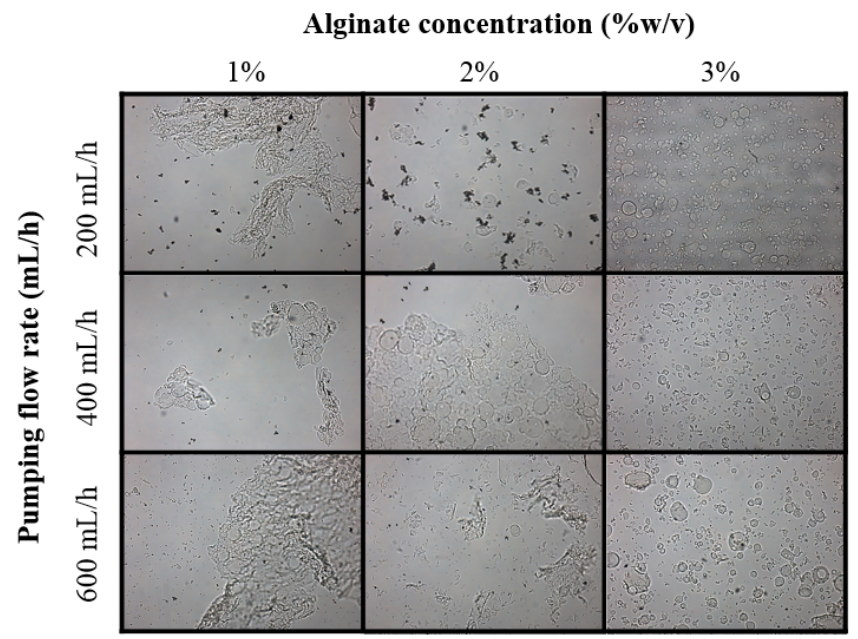
Figure 1. Optical microscopy (60×) of microparticles obtained under different processing conditions: alginate concentration (1, 2 and 3% w / v ) and pumping flow rate (200, 400 and 600 mL/h). Other working conditions of the AAJ: CaCl 2 concentration: 0.25 M; distance: 25 cm; air pressure: 1.5 bar.